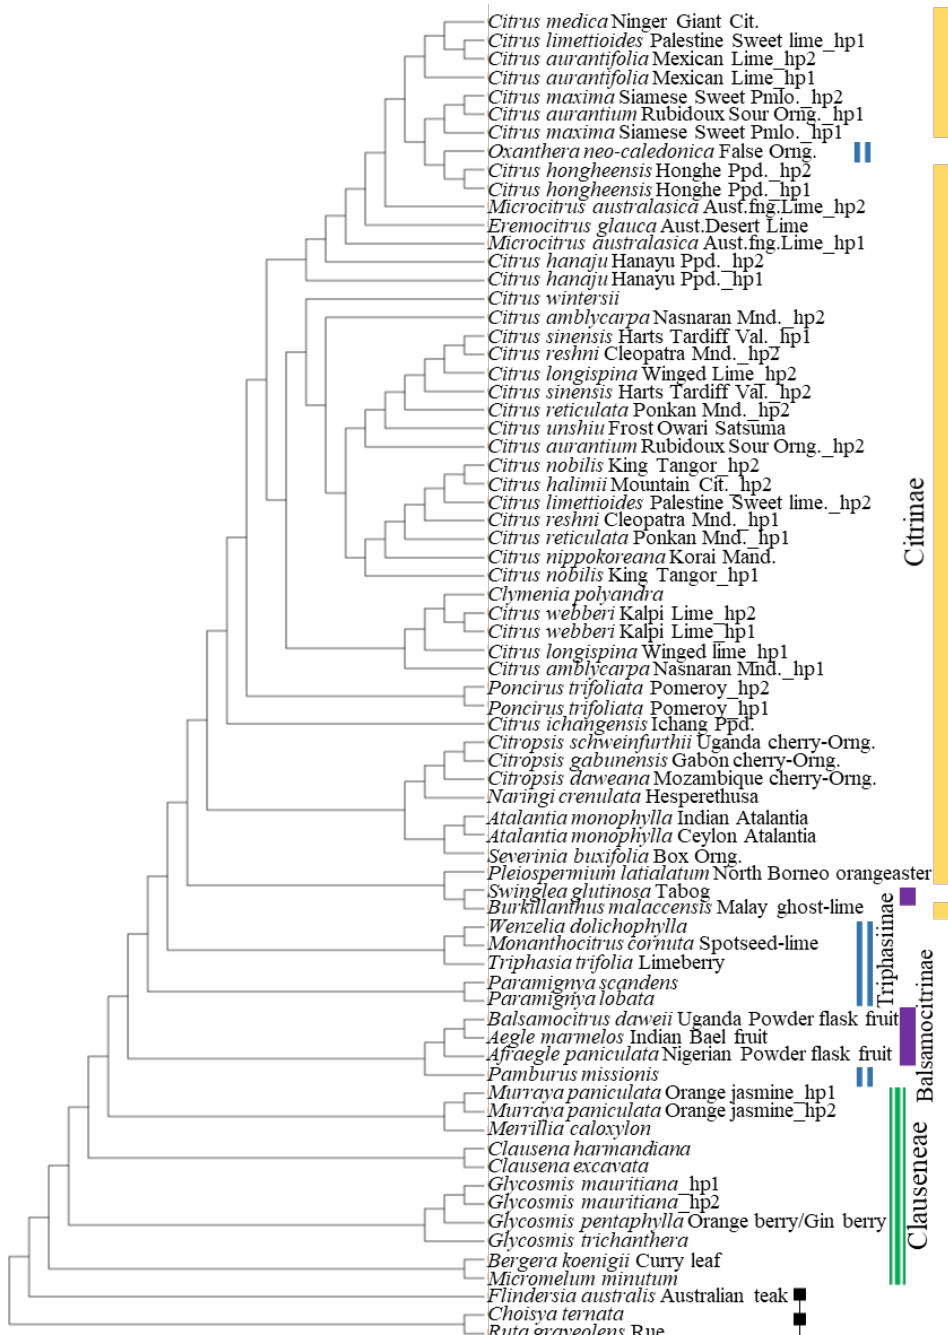
Figure 1. Cladogram constructed using 900 bp sequence of malate dehydrogenase gene fragment. The Maximum Parsimony (MP) tree constructed using MEGA X had a length of 851, consistency index was 0.7529 (0.6366), the retention index was 0.8069 (0.8069), and the composite index was 0.6076 (0.5137) for all sites and for parsimony-informative sites (in parentheses). The MP tree was obtained using the Subtree-Pruning-Regrafting algorithm. The aligned file with 72 sequences had a total of 954 positions in the final dataset. Clusters representing major groups of Aurantioideae are indicated. Three non-Aurantioid taxa, Flindersia australis , Choisya ternata and Ruta graveolens formed the outgroup for the cladogram. Common names for taxa are shown next to the scientific names. Hp1 and hp2 indicate haplotypes.